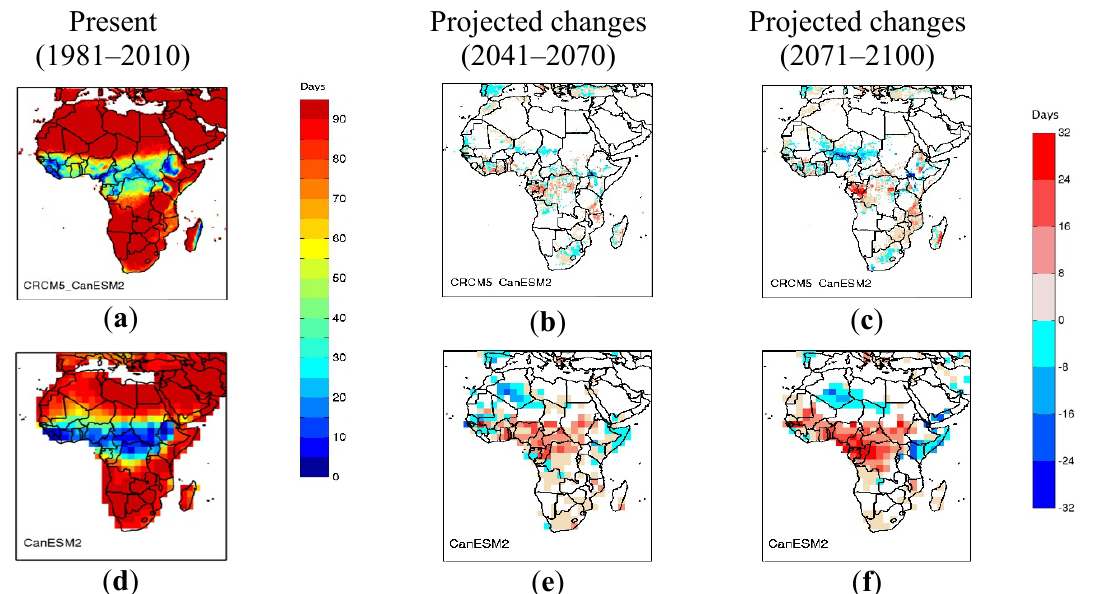
Figure 7. Same as Figure 6, but for the mean number of dry days for boreal